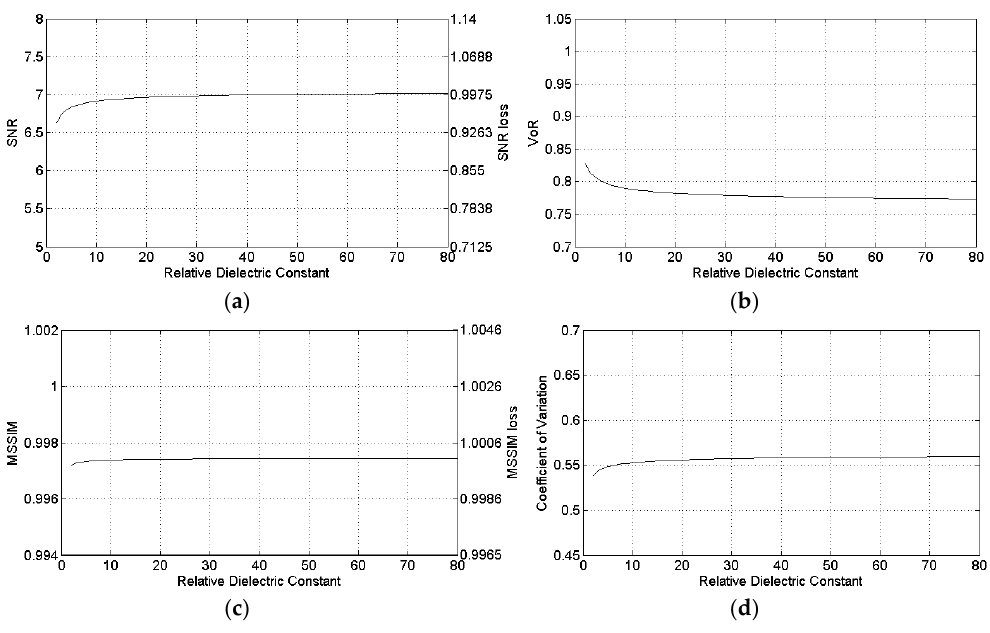
Figure 8. Sensitivity of SB-SARBM3D against the relative dielectric constant: ( a ) SNR; ( b ) VoR; ( c ) MSSIM; ( d ) coefficient of variation.